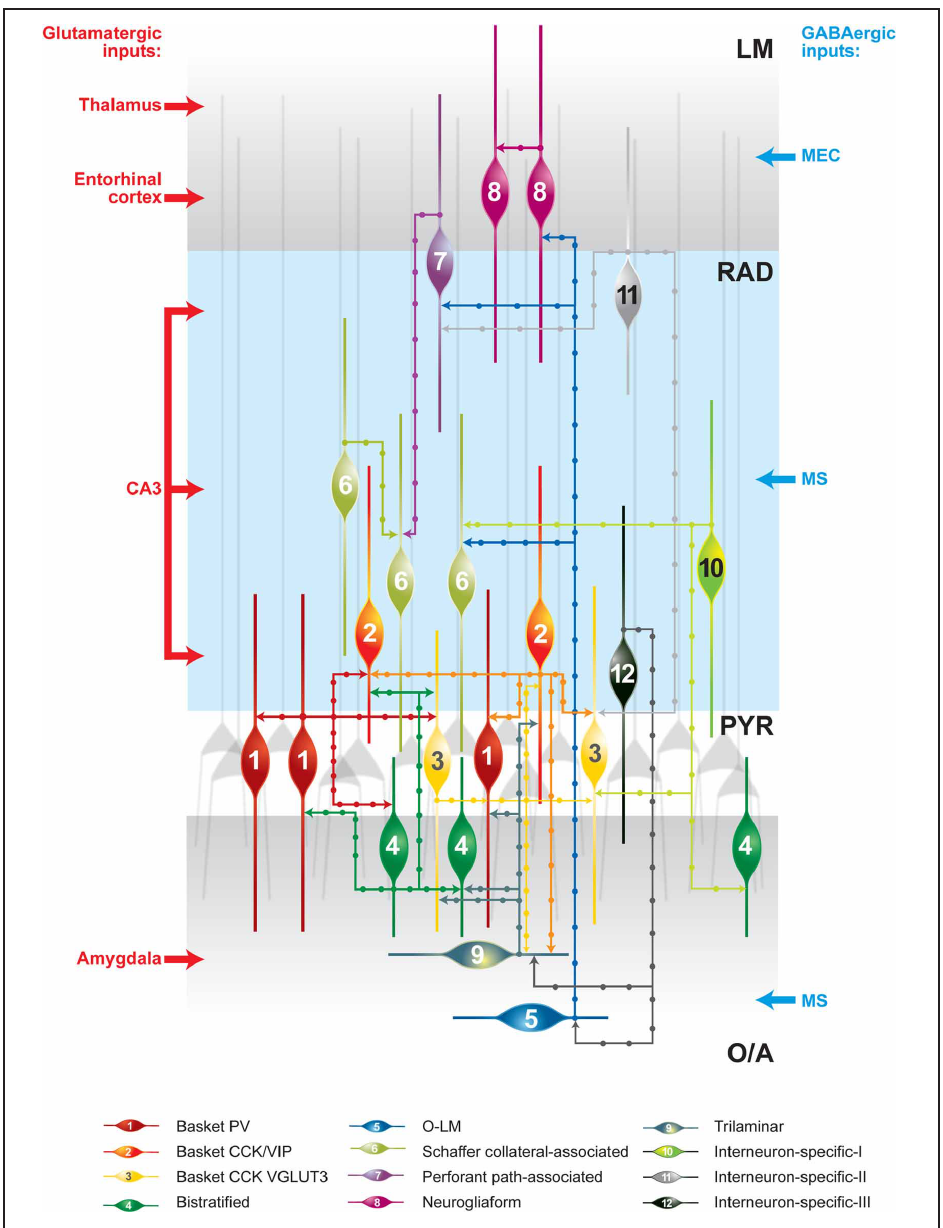
FIGURE 1 | Schematic representation of synaptically connected GABAergic inhibitory circuits in the CA1 hippocampal area. The main glutamatergic inputs are indicated on the left. The main long-range GABAergic projections contacting CA1 interneurons are shown on the right. Some connections are indicated on the basis of data from one recording and further analysis may be required. CCK, cholecystokinin; LM, stratum lacunosum moleculare; O/A, stratum oriens/alveus; O–LM, oriens–lacunosum moleculare cell; PV, parvalbumin; PYR, stratum pyramidale; RAD, stratum radiatum; VGLUT3, vesicular glutamate transporter 3; VIP, vasoactive intestinal peptide.